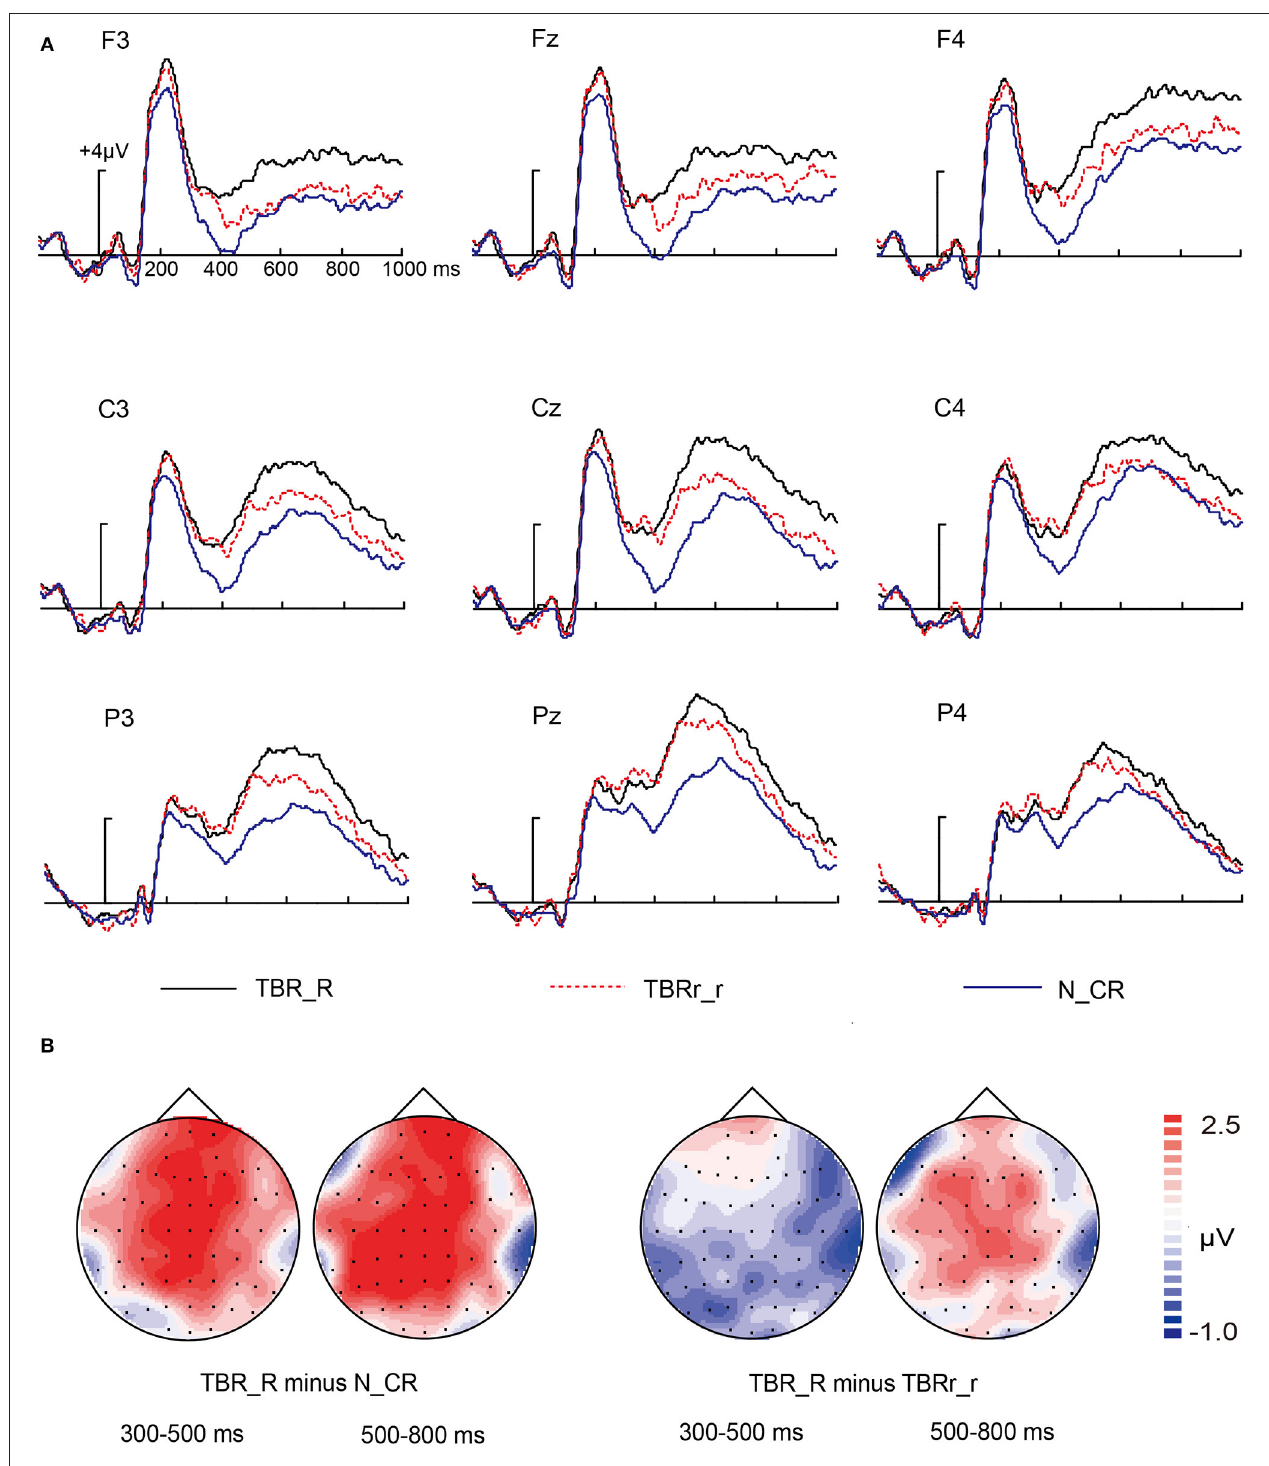
FIGURE 3 | ERP for TBR_R, TBRr_r, and N_CR condition. (A) Waveforms are shown from F3, Fz, F4, C3, Cz, C4, P3, Pz, and P4 electrodes. (B) The left two topographical plots depict ERP differences between TBR_R condition and N_CR condition at 300–500ms interval and 500–800 ms interval; the right two topographical plots depict ERP differences between TBR_R condition and TBRr_r condition at 300–500ms interval and 500–800ms interval.